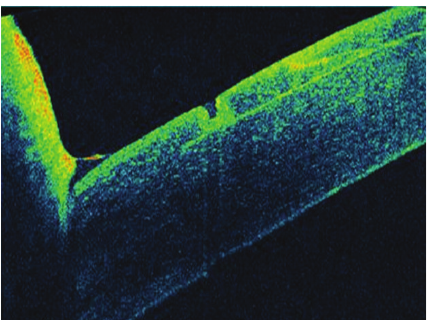
Figure 3: In the lower quadrant, the cut done primarily with the microkeratome opened up from inside after colliding with the new femtosecond flap, leading to an epithelial defect that was visualized with the OCT system.